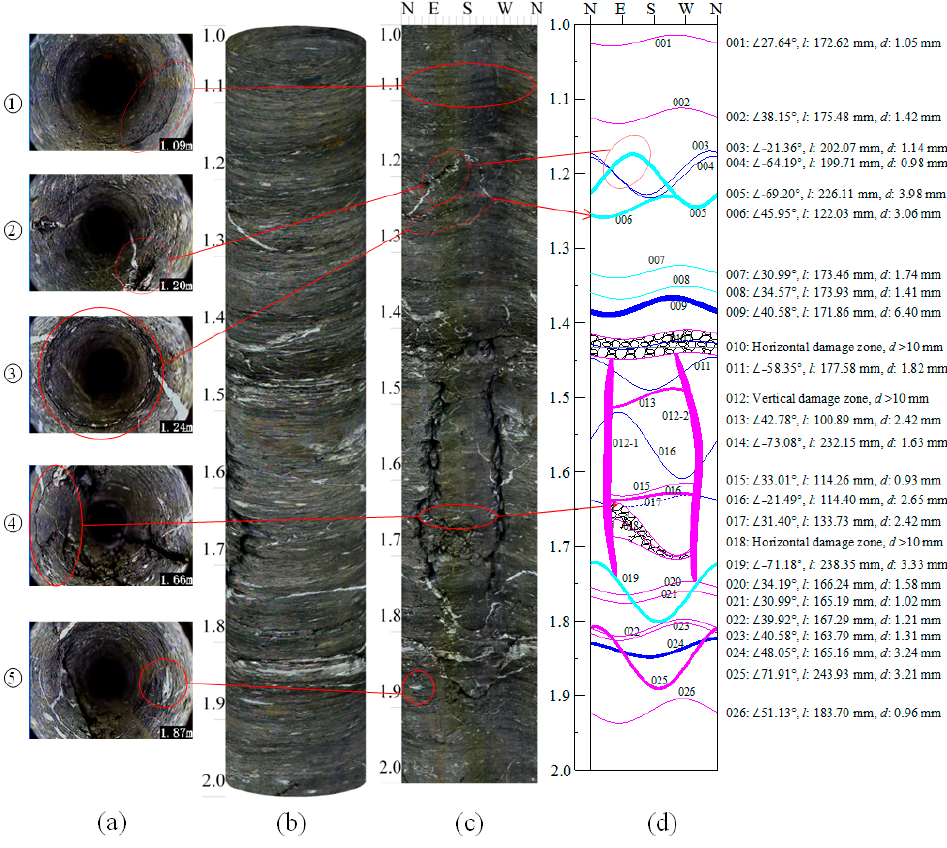
Figure 11. ( a ) Typical point; ( b ) virtual map of borehole image in 3-D; ( c ) plan view of the drill hole; ( d ) measurements of natural fracture (NF).